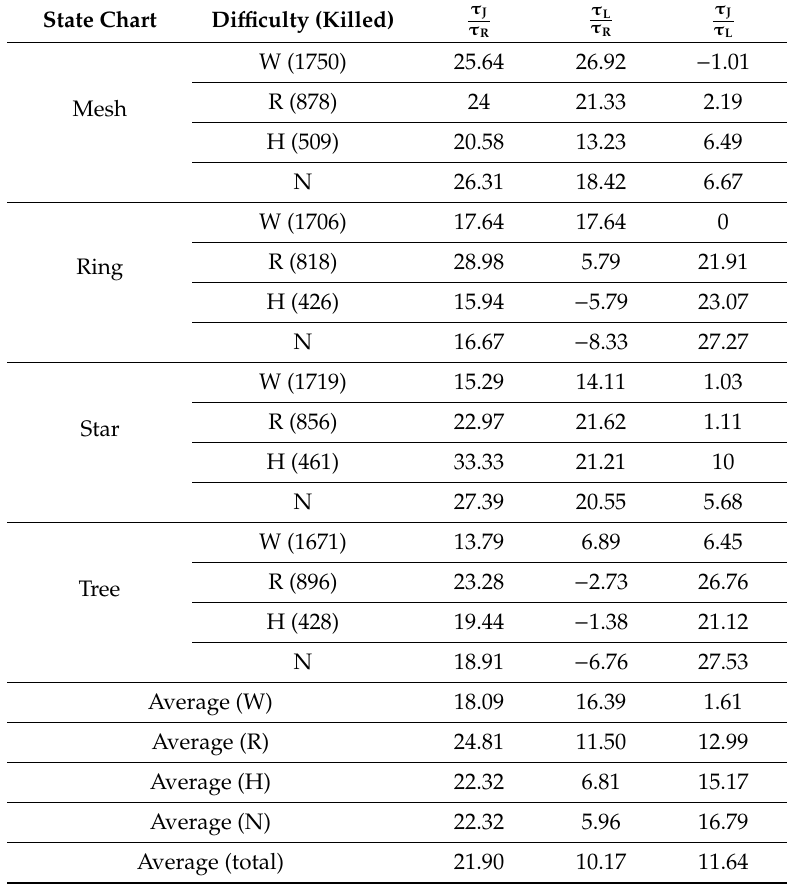
Table 5. Comparison of performance between methods based on mean suspiciousness